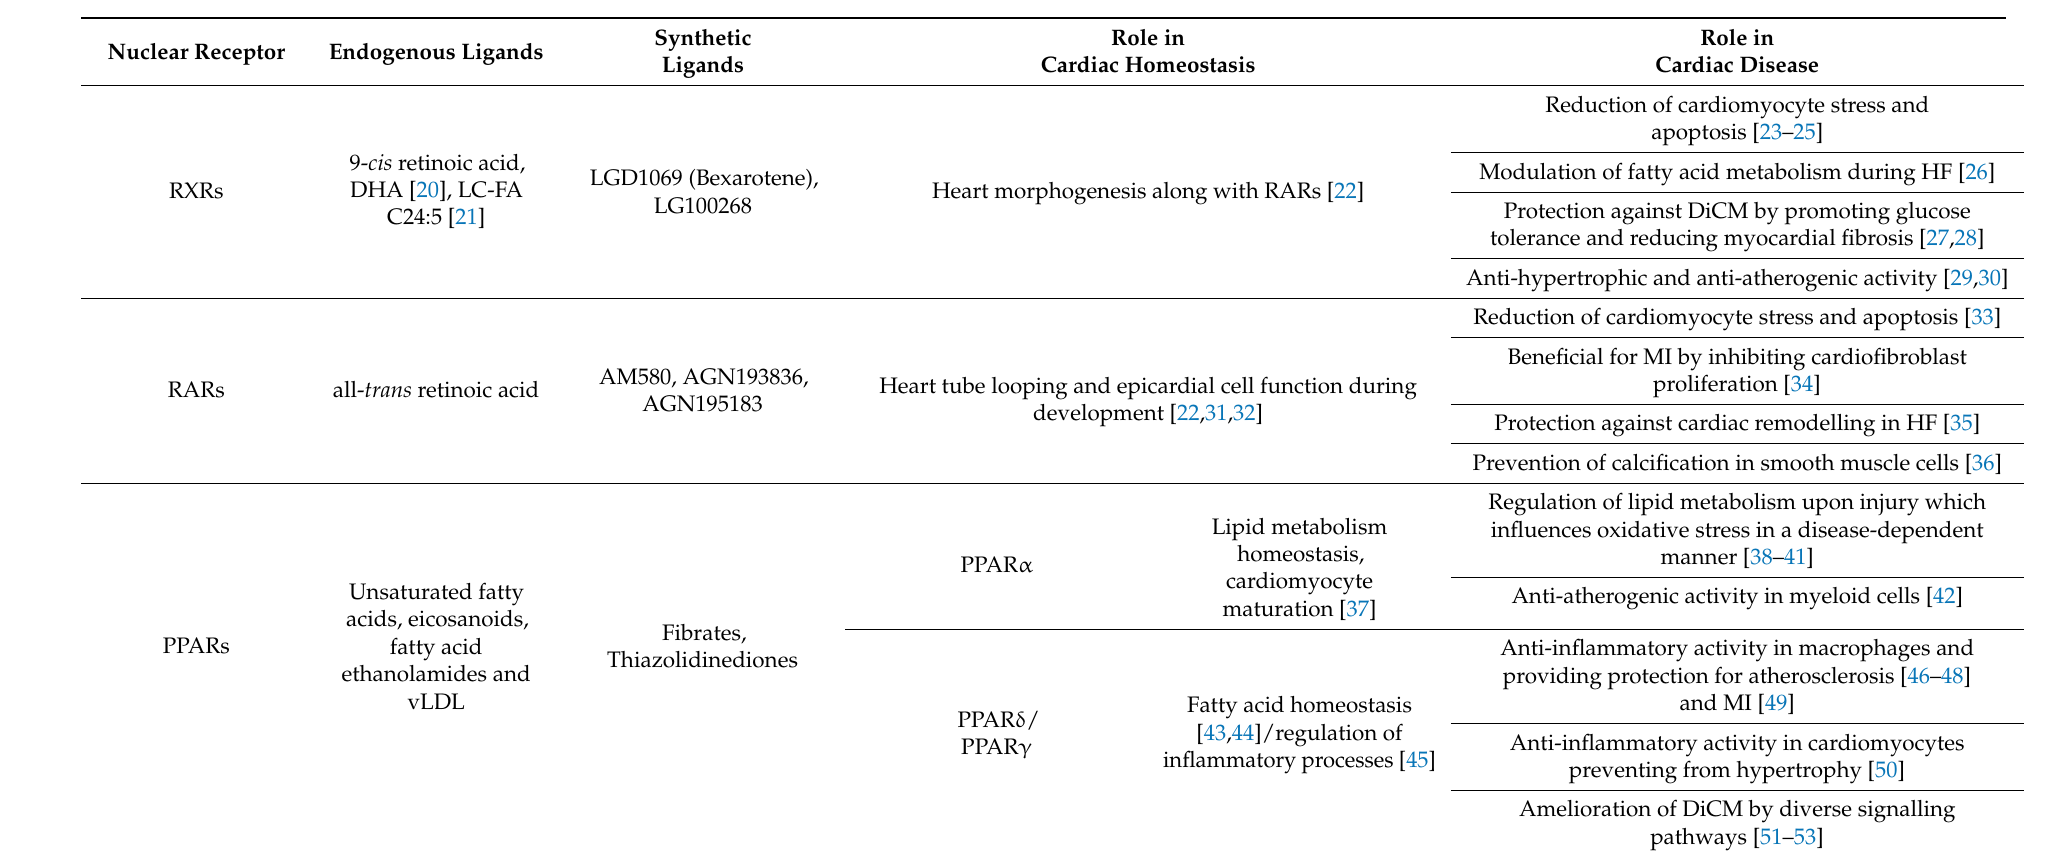
Table 1. RXR partnership biology in CV homeostasis and disease. RXRs, Retinoid X Receptors. RARs, Retinoic Acid Receptors. PPARs, Peroxisome proliferator-activated receptors. LXRs, Liver X Receptors. TRs, Thyroid Hormone Receptors. VDRs, Vitamin D Receptors. DHA, docosahexaenoic acid. vLDL, very low-density lipoprotein. HF, heart failure. DiCM,